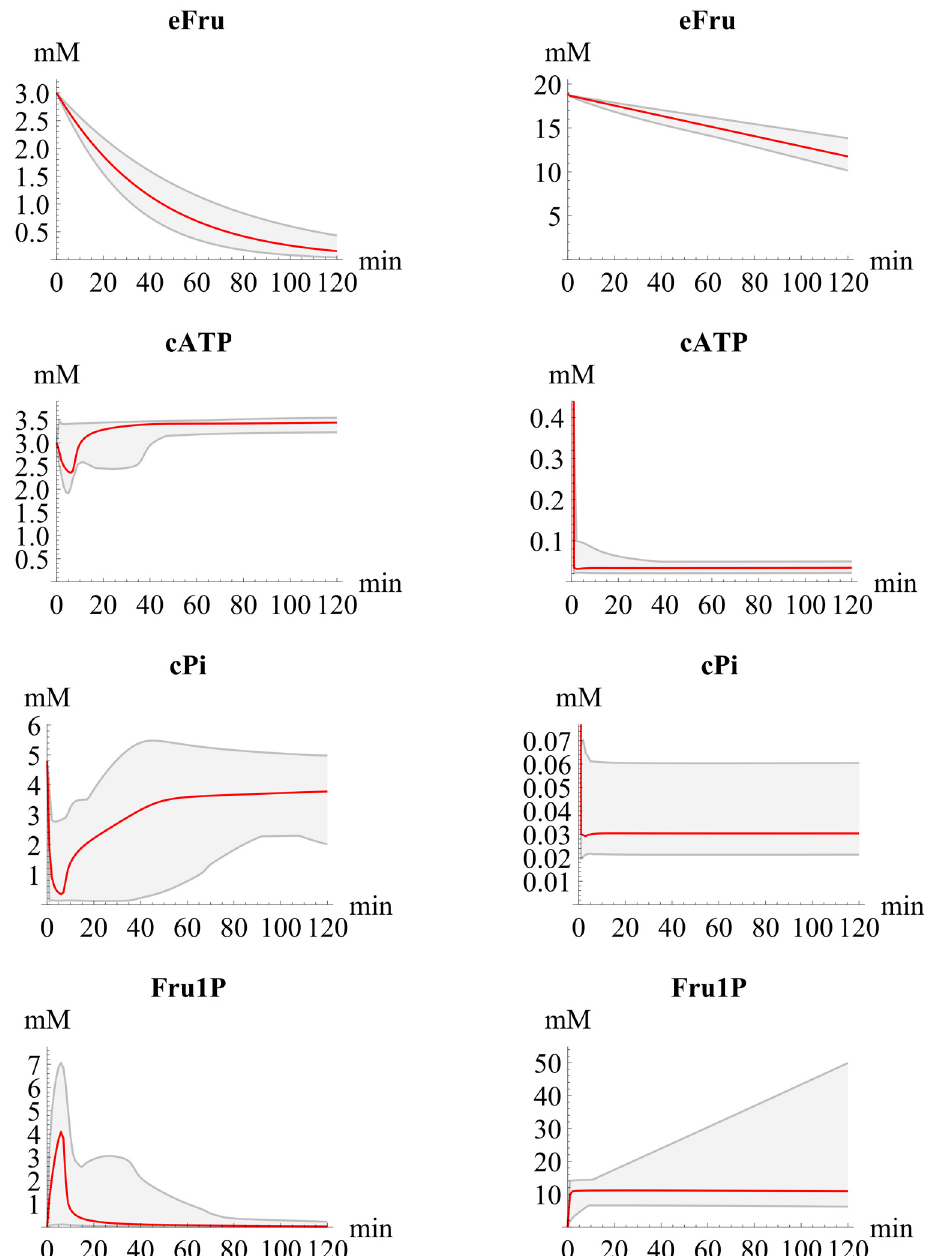
Fig 4. Plot of the simulated concentrations over time for extracellular fructose (eFru), fructose 1-phosphate (Fru1P), cytosolic phosphate (cPi) and cytosolic ATP (cATP). Specifically, the simulated concentrations in hepatocytes incubated with 20 mM glucose and 3 mM fructose (conditions A1 and A2, described in the main text) or 20 mM glucose and 20 mM fructose (condition B, described in the main text) are shown. The red plot indicates the values predicted with the best fit parameter set and the grey area indicates the estimated range of variations taking parameter sets within the 95% confidence intervals derived from the identifiability